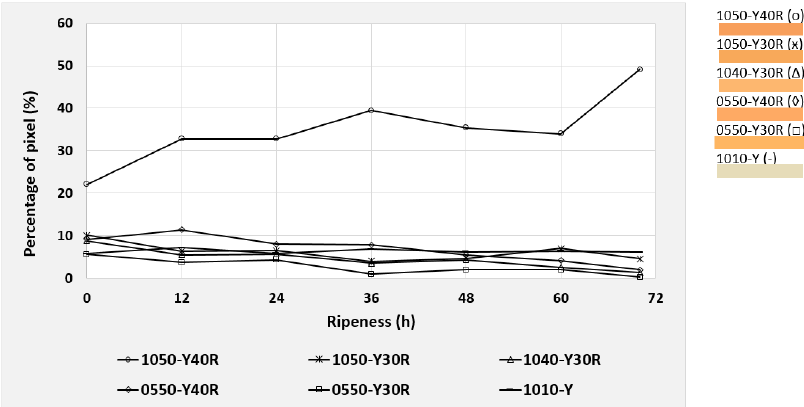
Figure 11. Development of the six most dominating peel colors of cv. “Nam Dokmai” mangos during the 70 h post-ripening process, presented as NCS color codes.